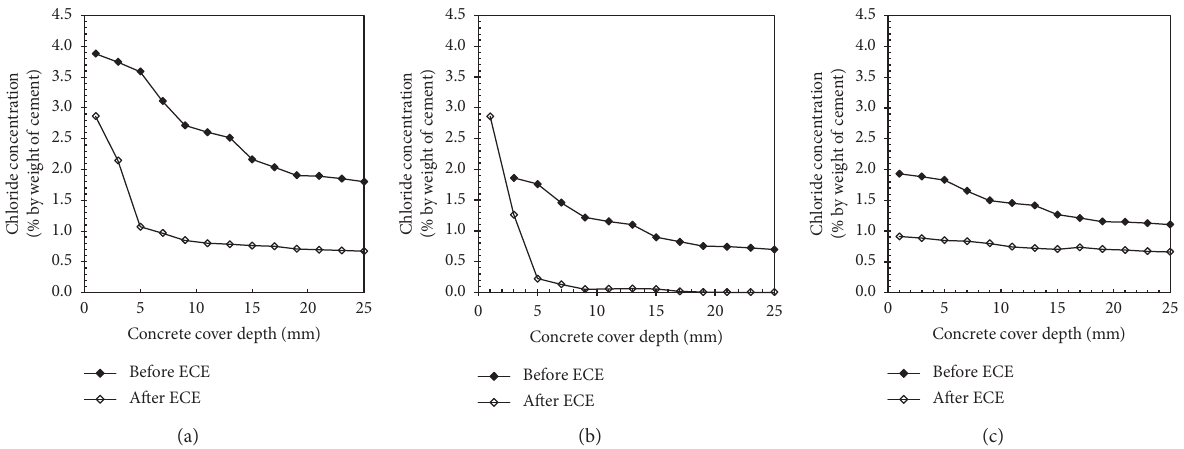
Figure 6: Chloride profiles before and after treatment using lithium borate as electrolyte for at 2A/m 2 constantly for 4 weeks, in terms of (a) total ∗ , (b) free ∗∗ , and (c) bound ∗∗∗ chlorides. ∗ (a) Total: acid soluble titration against silver nitrate at the ambient temperature. ∗∗ (b) Free: water soluble chlorides dissolved in 50 ° C distilled water. ∗∗∗ (c) Bound: value obtained by subtracting the free chlorides concentration from the total at each depth.